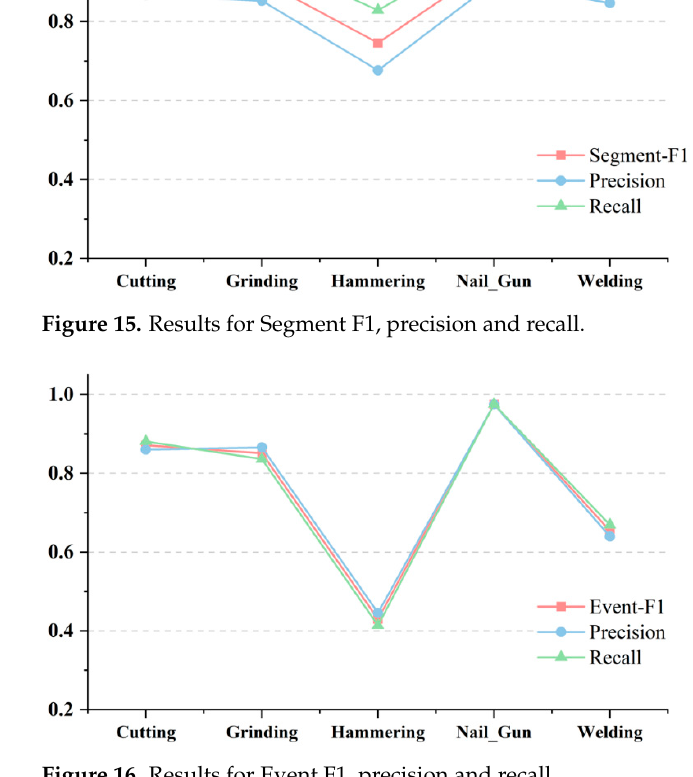
Figure 16. Results for Event F1, precision and recall.